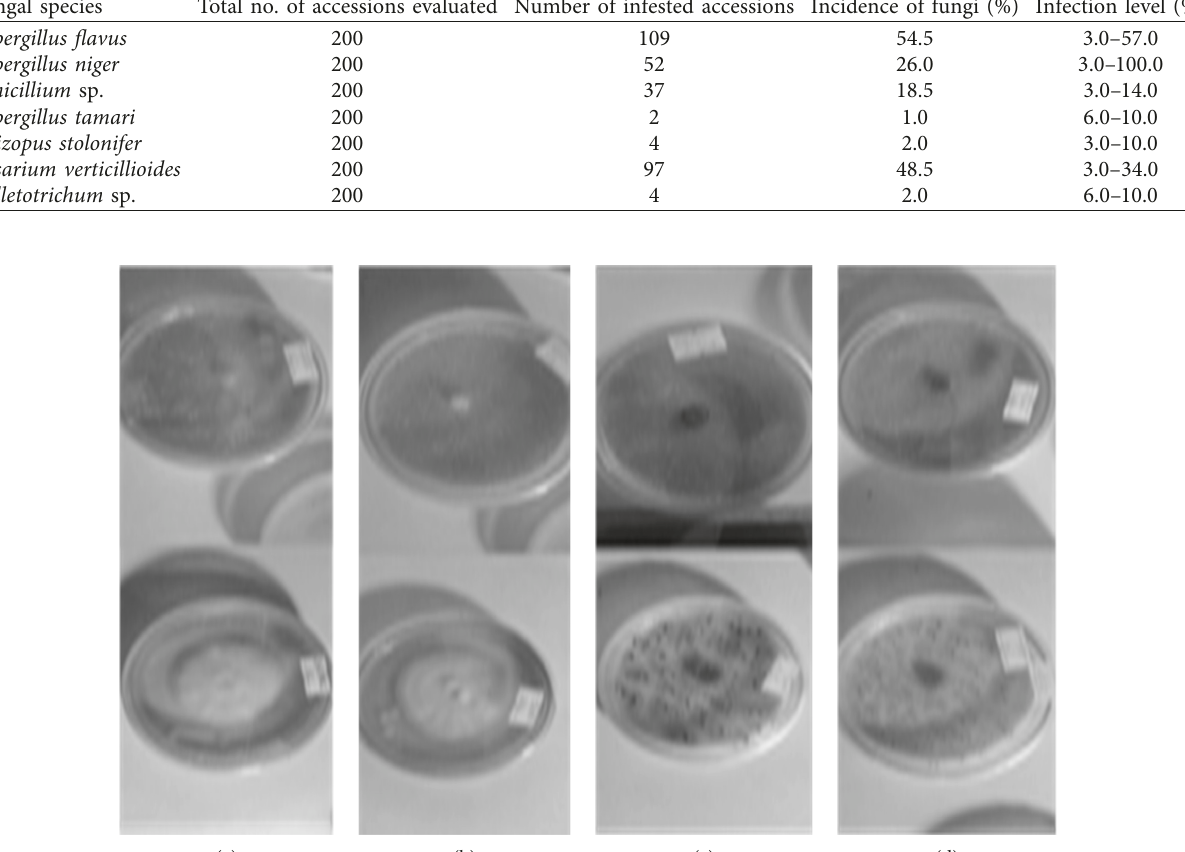
Table 1: Incidence of infection (%) and infection level (%) by fungal species from cowpea seed samples. Fungal species